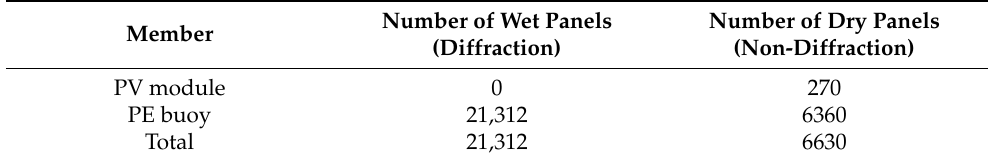
Table 3. Mass information according to two mass distribution cases.